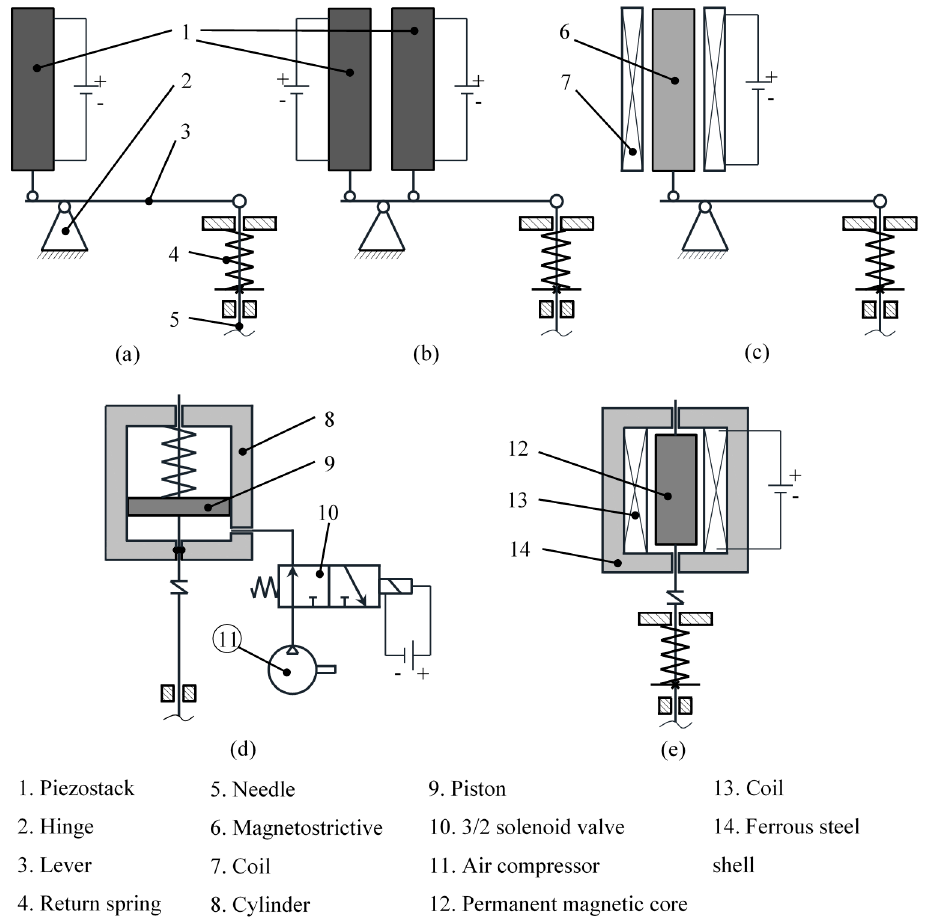
Figure 2. Schematic diagram of four actuators. ( a ) Using one piezo-stack and amplification mechanism; ( b ) using two piezo-stack and amplification mechanism; ( c ) using a giant magnetostrictive and amplification mechanism; ( d ) using an electro-pneumatic actuator; and ( e ) using a linear moving magnet actuator.